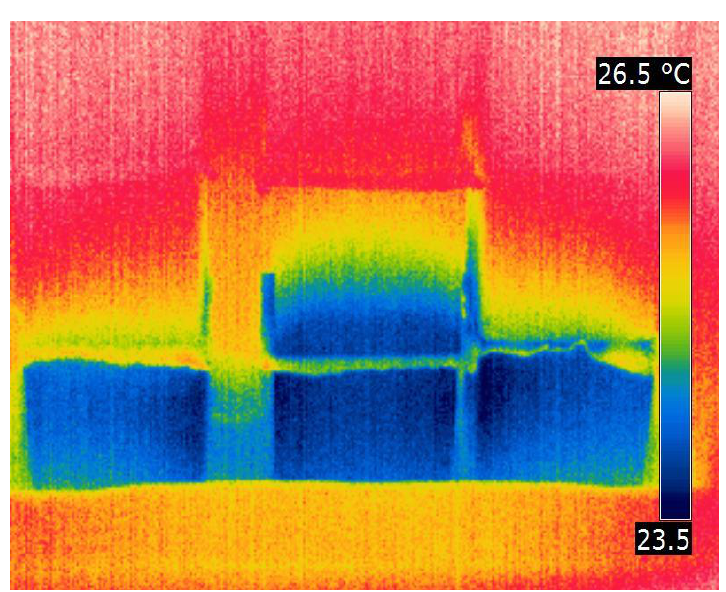
Figure A1. Thermographic report dated September 21, 2018, for Carparo (C.), Lecce stone (L.S.), and Tuff (T.).